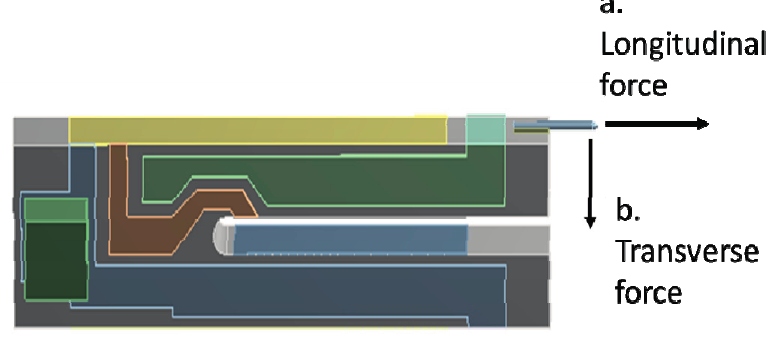
Figure 15. A schematic of the TF-probe under longitudinal and transverse